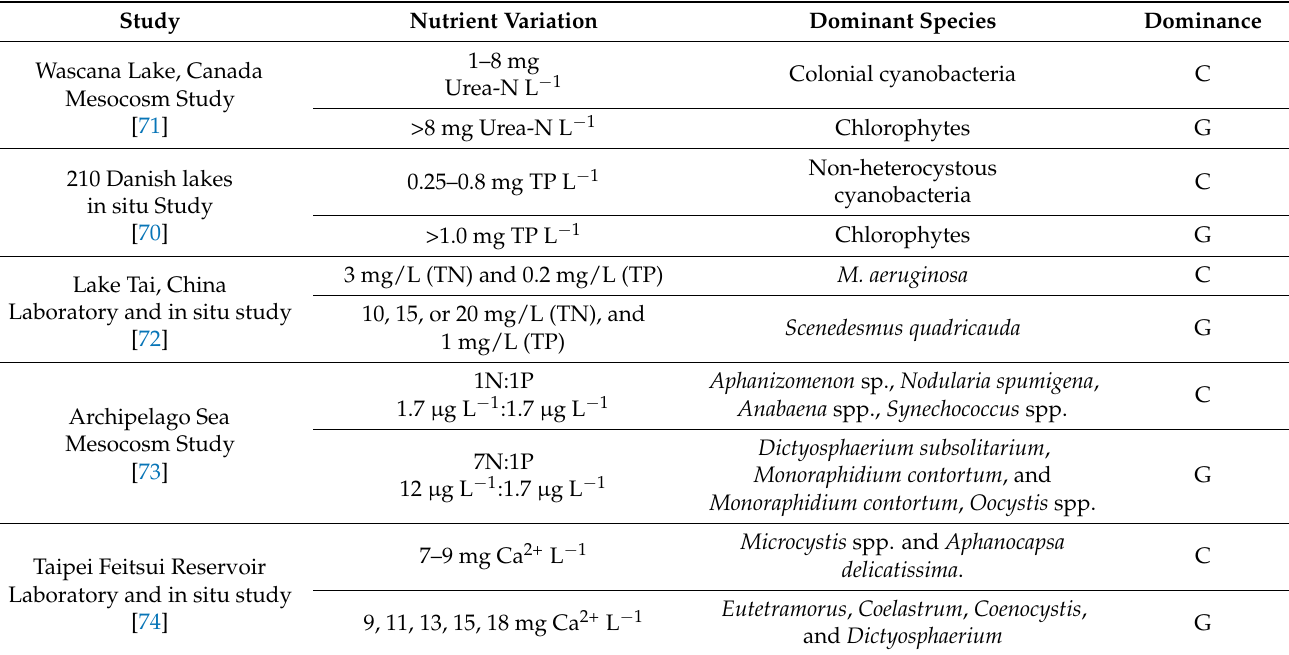
Table 2. Case studies of nutrient manipulation on phytoplankton in situ, in the mesocosm study, and in laboratory conditions showing lower nutrient requirements of cyanobacteria than eukaryotic algae. “C” represents cyanobacteria; “G” represents green algae. DIN: dissolved inorganic nitrogen; SRP: soluble reactive phosphorus; TN: total nitrogen; and TP: total